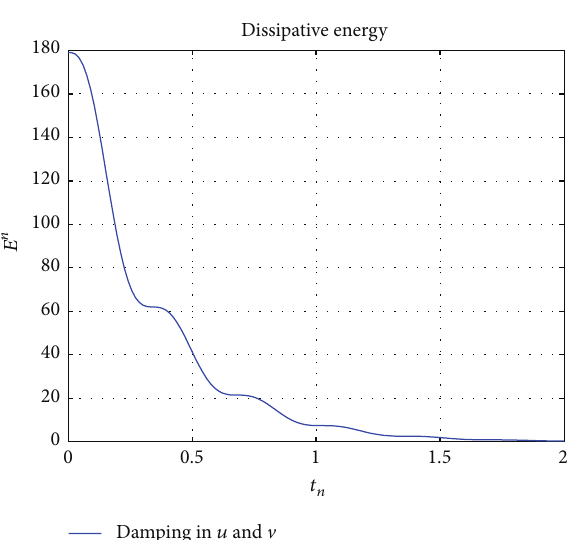
Figure 9: Δ𝑡/Δ𝑥 = 0.7680 .